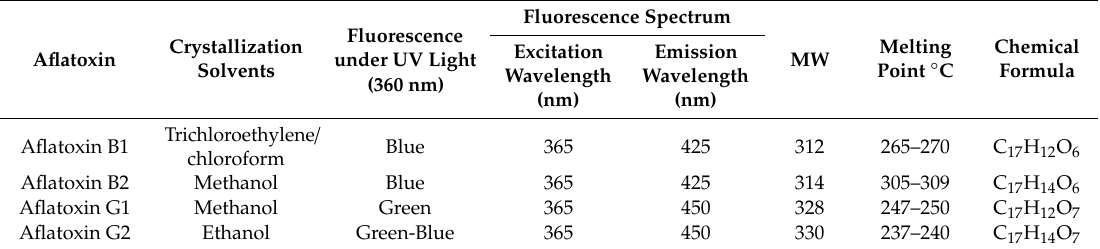
Table 1. Main physicochemical properties of aflatoxins as originally determined by Hartley, Nesbitt and O’Kelly